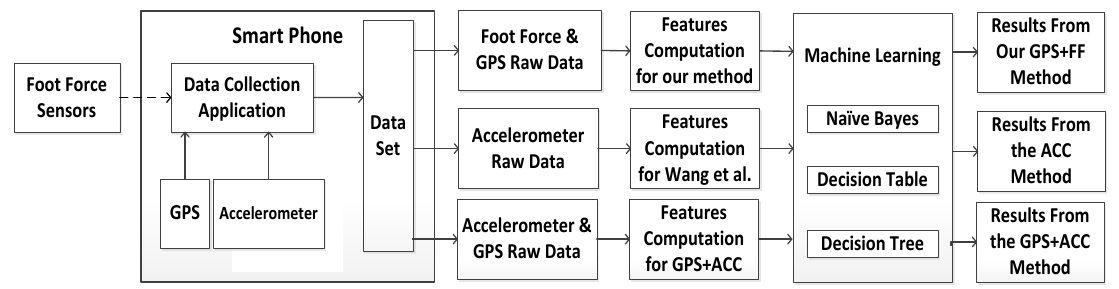
Figure 1. Architecture of the mobility activity recognition